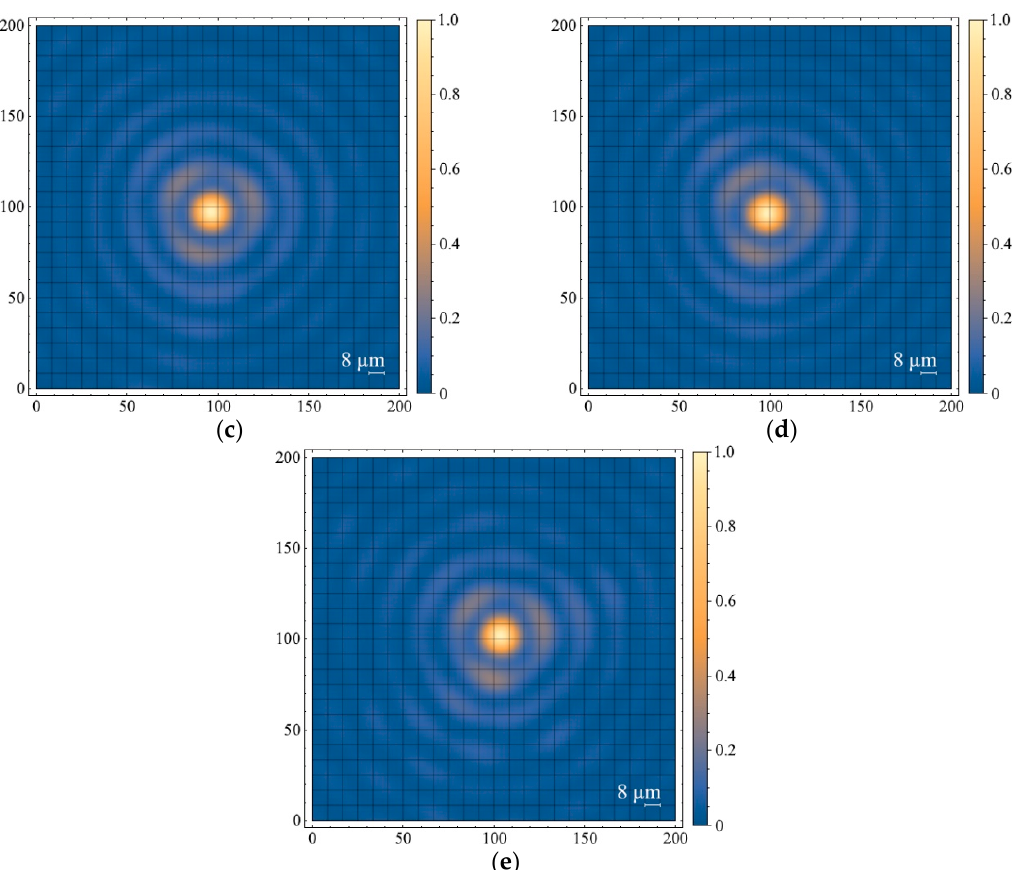
Figure 4. Cross sections of field intensity: ( a ) without binary mask, d = 0 mm, D → ∞ ; ( b ) with binary mask, d = 4 mm, D → ∞ , Z ap = 240 mm; ( c ) with binary mask, d = 0, D = 7 mm, Z ap = 360 mm; ( d ) with binary mask, d = 4, D = 7 mm, Z ap = 240 mm; ( e ) with binary mask, d = 4, D = 7 mm, Z ap = 360